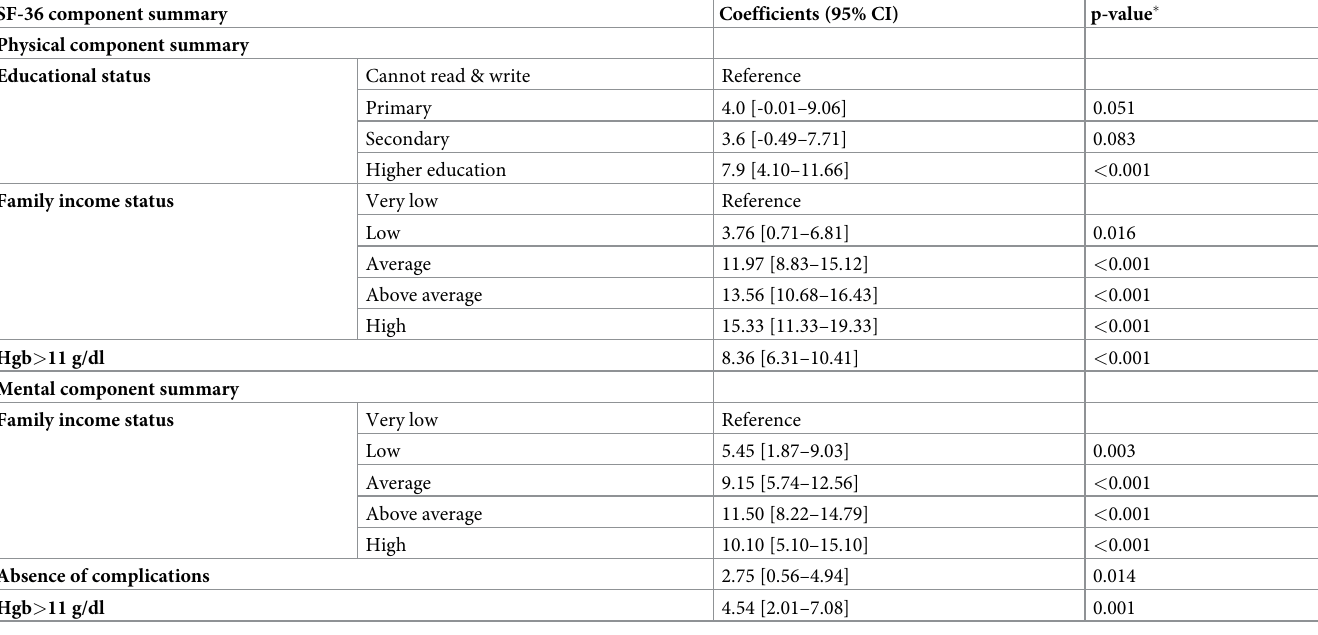
Table 9. Adjusted analysis for predictors of physical and mental component summaries of the Short Form (SF-36) among chronic kidney disease patients. SF-36 component